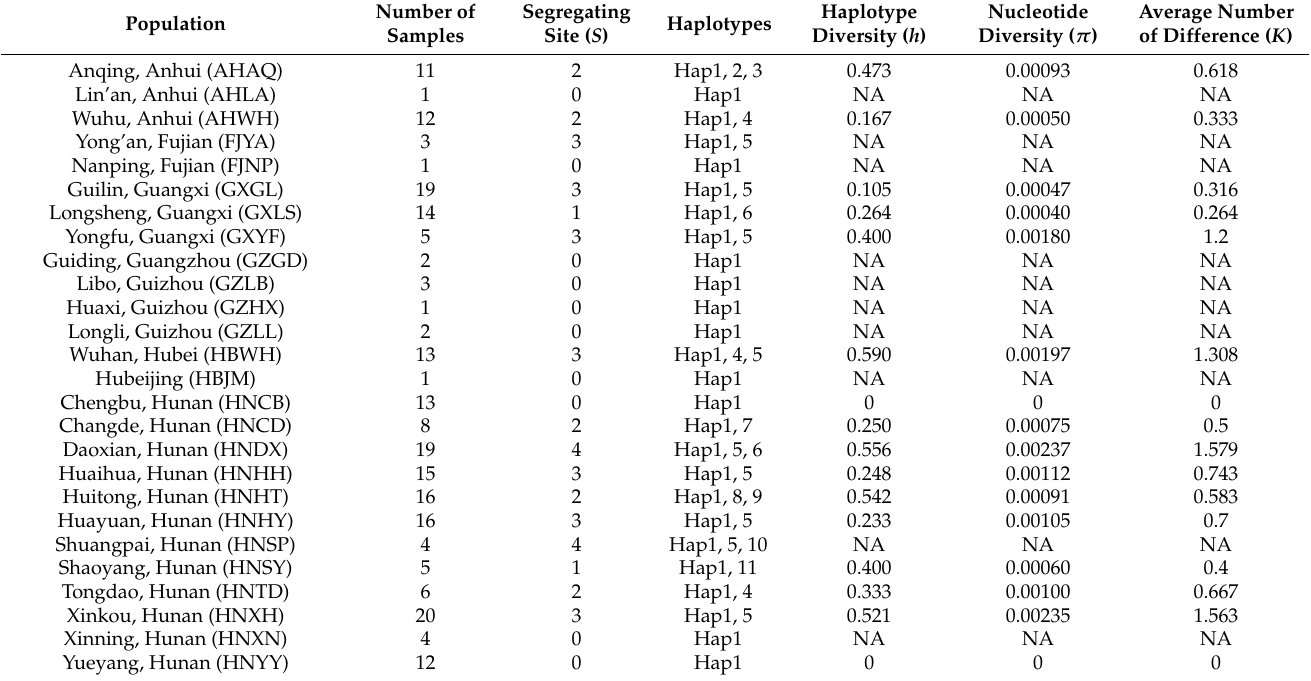
Table 2. Genetic variation parameters of 37 various geographic